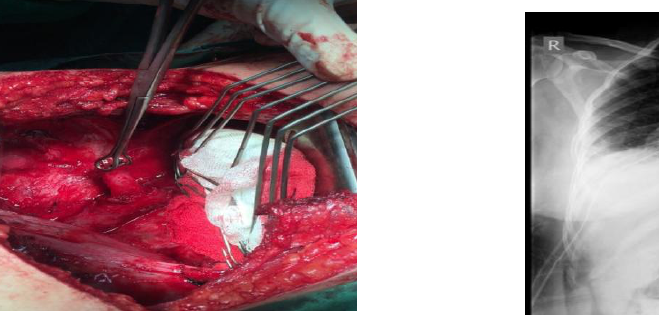
Figure 4. Postoperative barium swallow of the